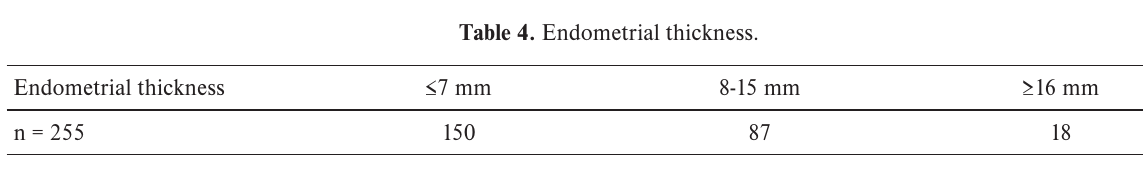
Table 5. Histopathological results.